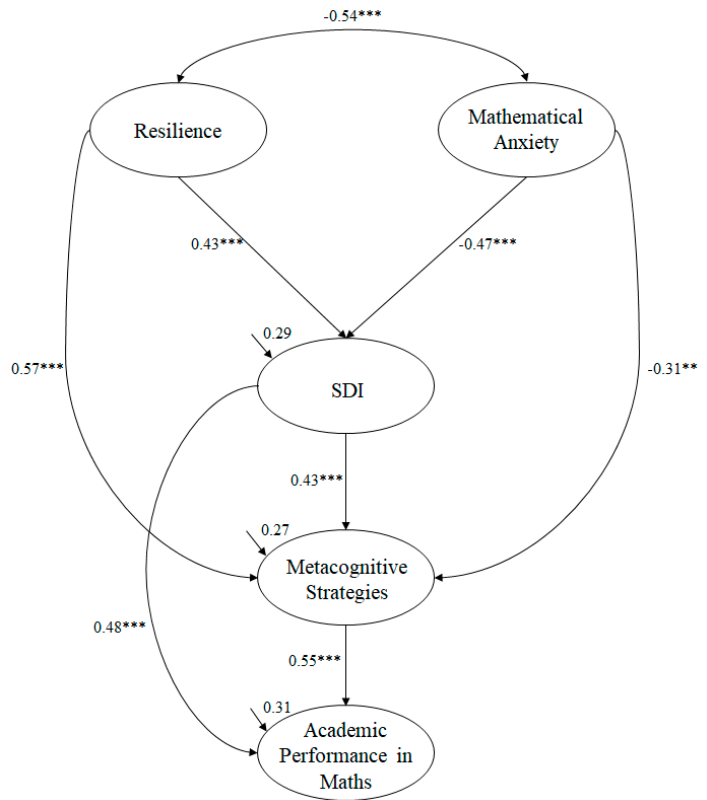
Figure 1. Structural equation model showing the relationships between variables. ** p < 0.01; *** p < 0.001.